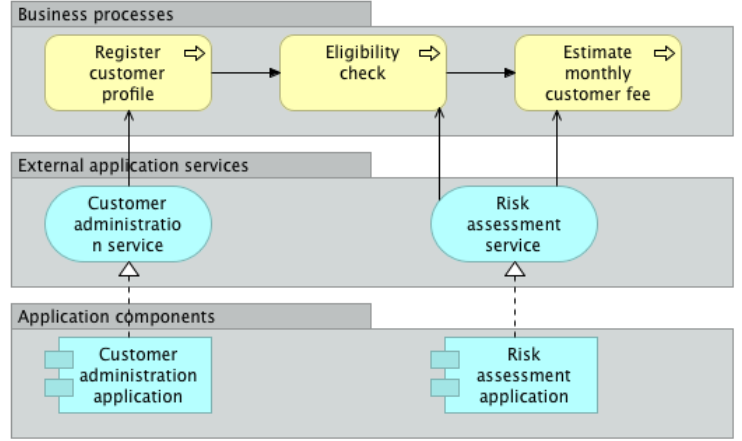
Figure 7. Application Usage